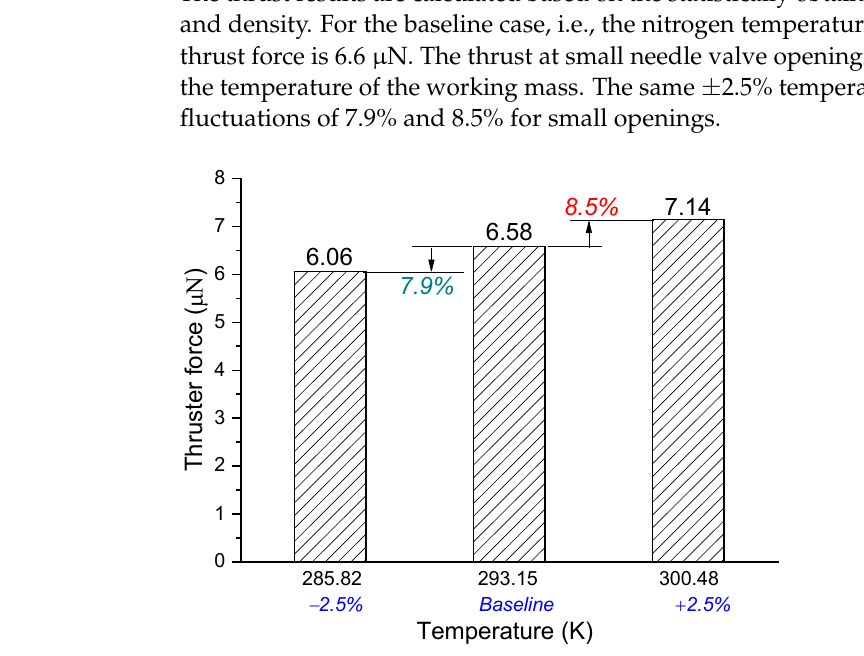
± 2.5% variation of gas